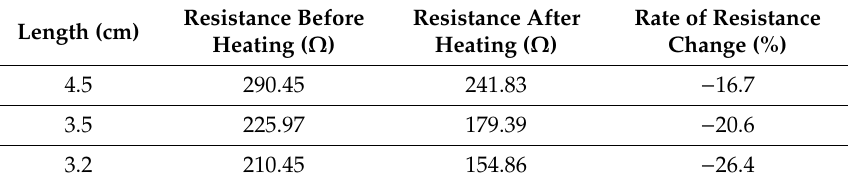
Table 4. Resistance change of yarn B at 80 ◦